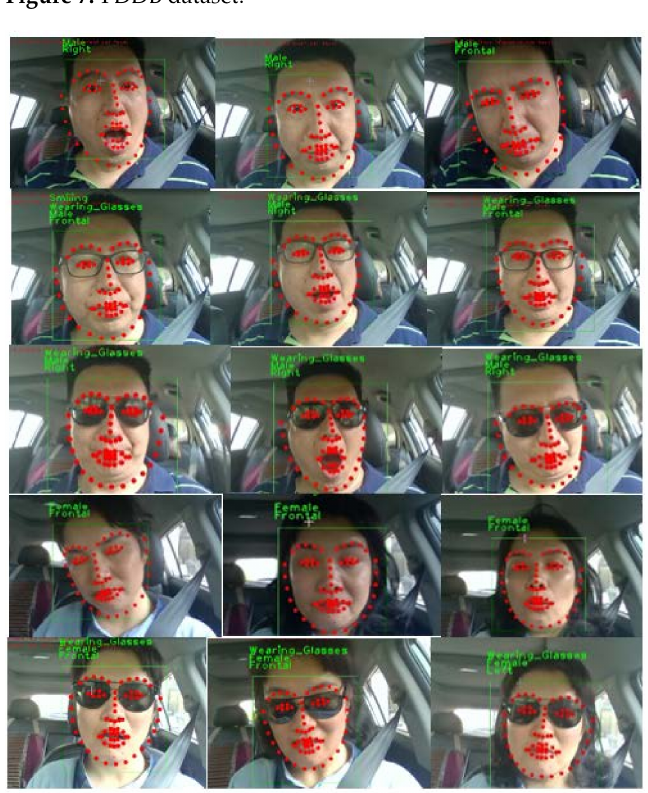
Figure 8. Face detection in different